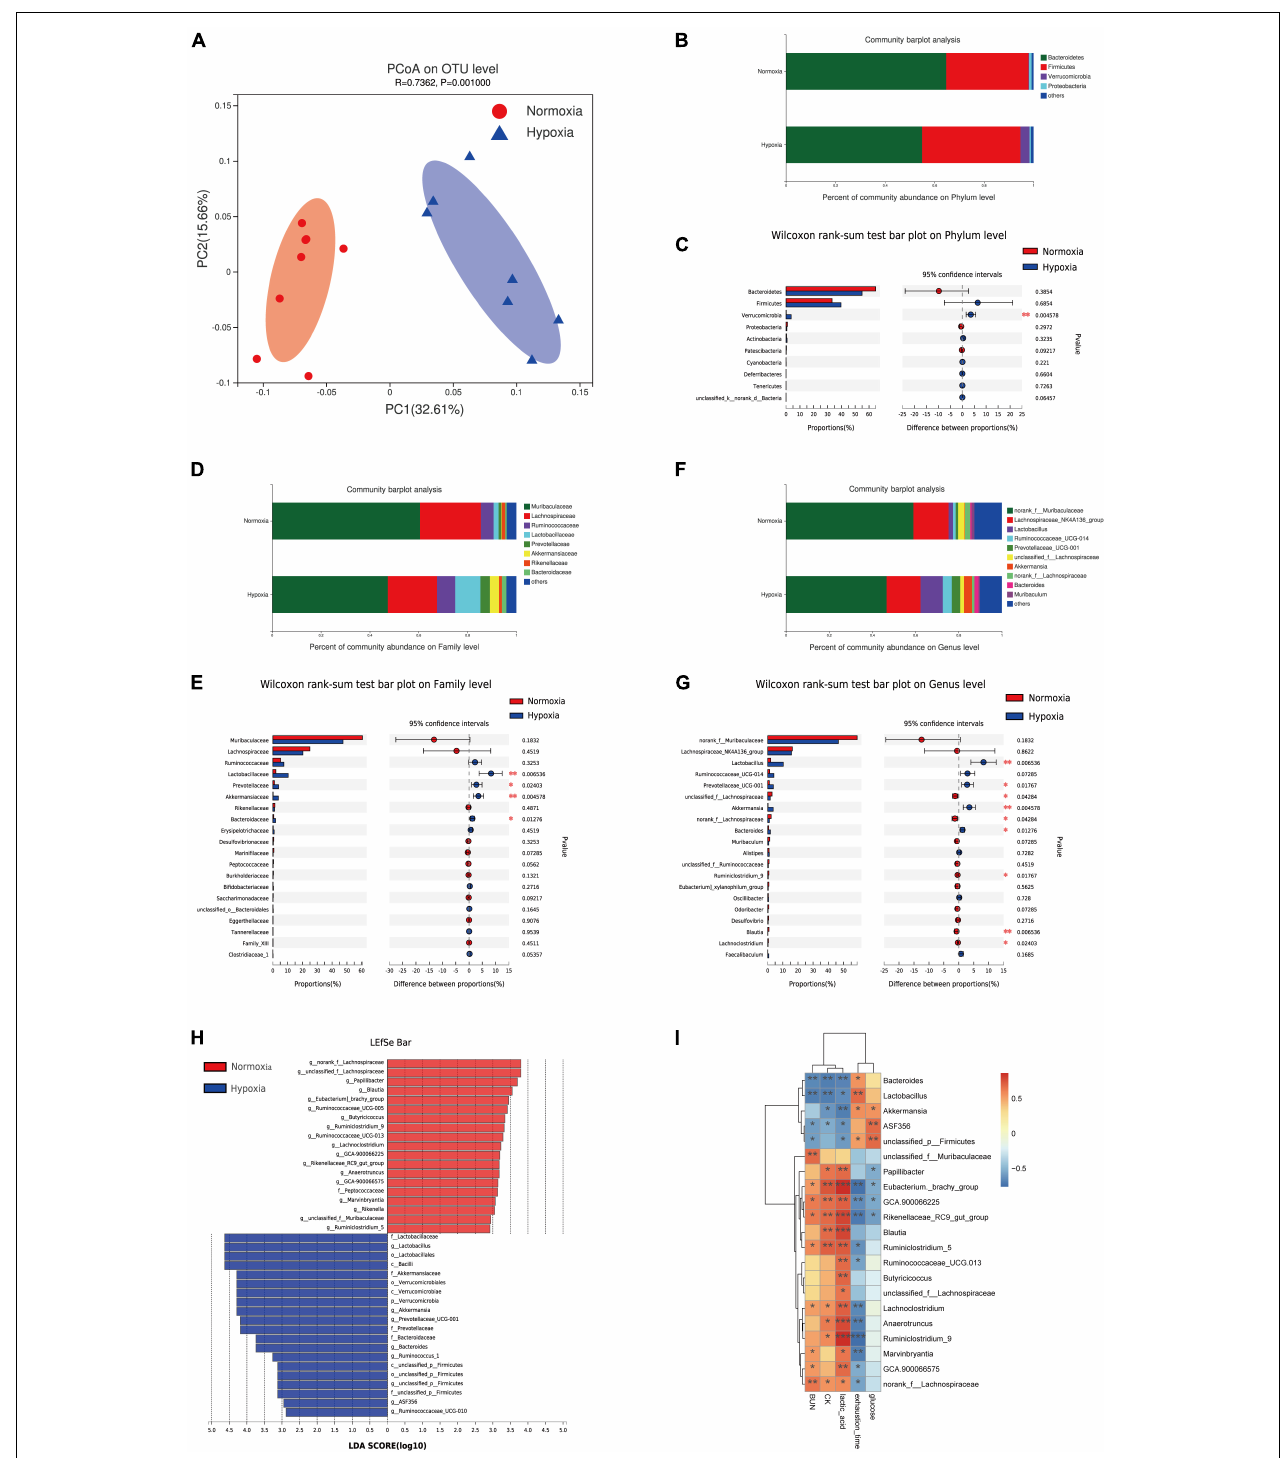
FIGURE 2 | Hypoxia treatment modified the gut microbiota. (A) Principal coordinate analysis (PCoA) of the β -diversity based on the unweighted UniFrac distance matrix (at the OTU level). Taxonomic distributions at the phylum level (B) , and the Kruskal-Wallis H test bar plot at the phylum level (C) . Taxonomic distributions at the family level (D) , and the Kruskal-Wallis H test bar plot at the family level (E) . Taxonomic distributions at the genus level (F) , and the Kruskal-Wallis H test bar plot at the genus level (G) . (H) Bar graph of linear discriminant analysis (LDA) scores, showing the biomarker taxa (LDA score of > 2 and a significance of p < 0.05 determined by the Wilcoxon signed-rank test). (I) Heatmap of Pearson’s correlation analysis between the key gut microbial taxa at the genus level and fatigue related factors. * p < 0.05, ** p < 0.01, *** p < 0.001.